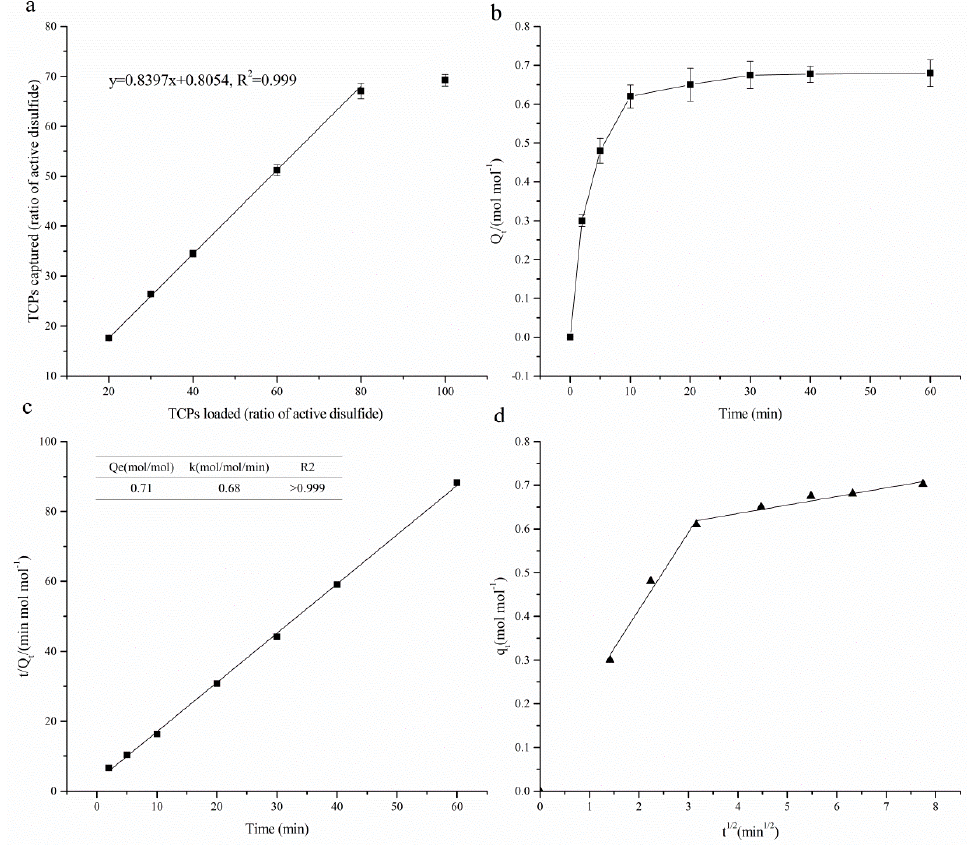
Figure 3. ( a ) effect of dosage of SGHs on the capture of TCPs by Thiopropyl Sepharose 6B; ( b ) contact time curve of the capture of TCPs; ( c ) plots of the pseudo-second order linearized kinetic model for the capture of TCPs; ( d ) plots of the Weber-Morris intra-particle diffusion for the capture of TCPs.